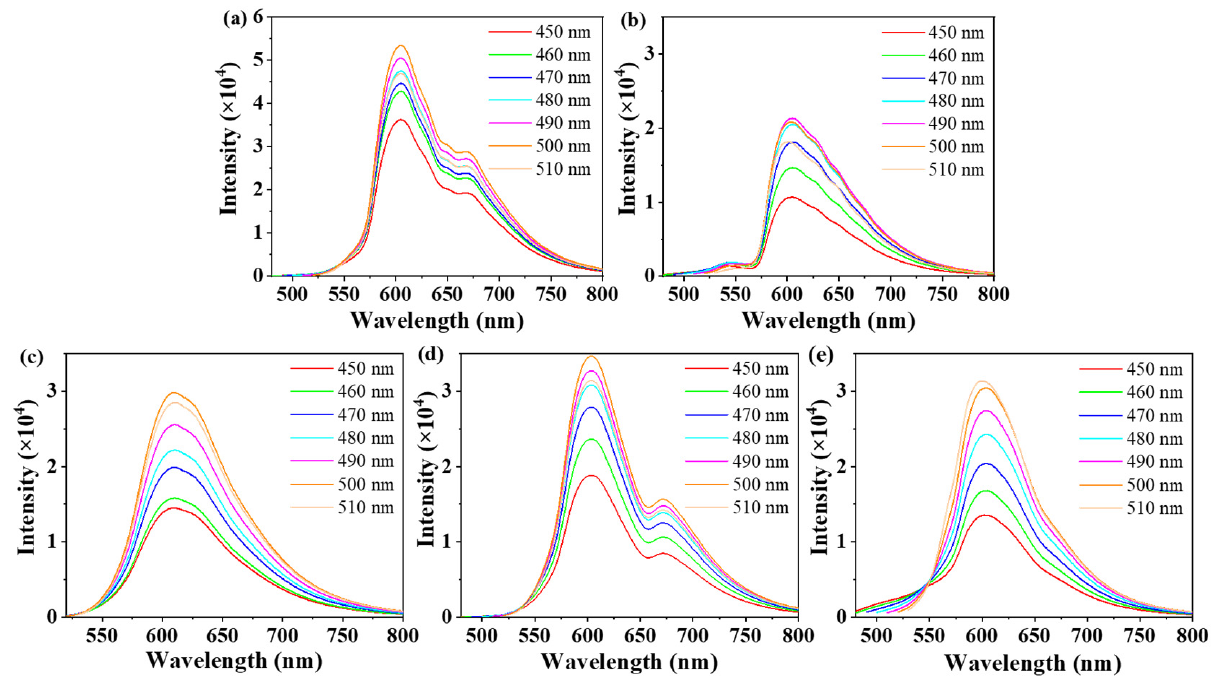
Figure 2. ( a – e ) PL emission spectra of CDs-1 to CDs-5 (0.1 mg/mL) in